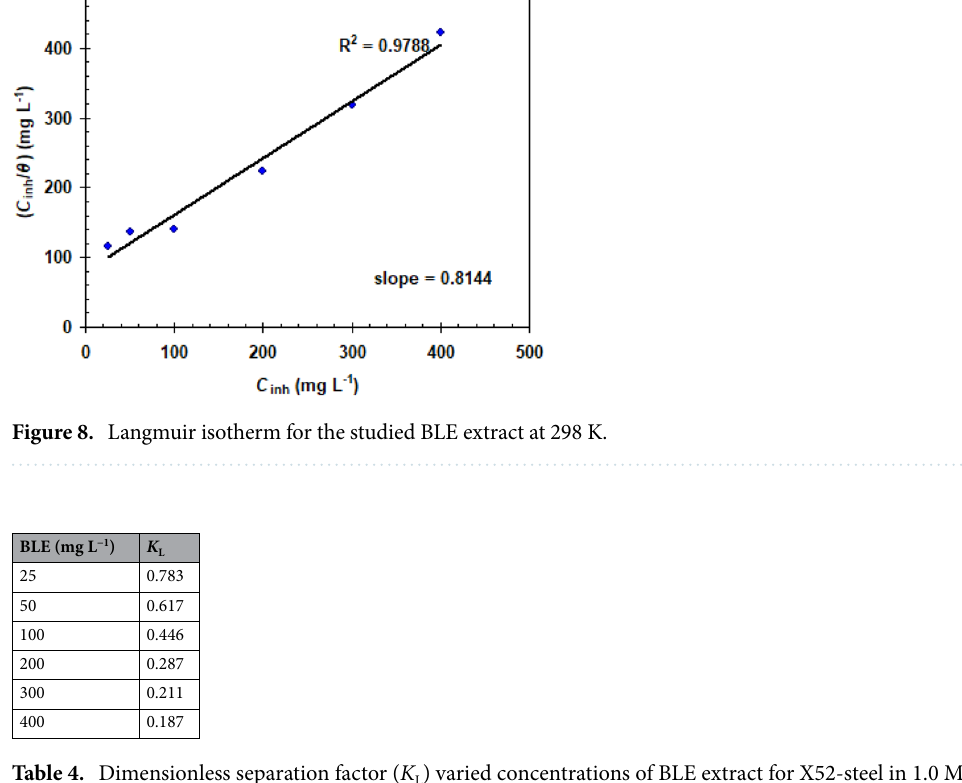
Table 4. Dimensionless separation factor ( K L ) varied concentrations of BLE extract for X52-steel in 1.0 M HCl at 298 K.